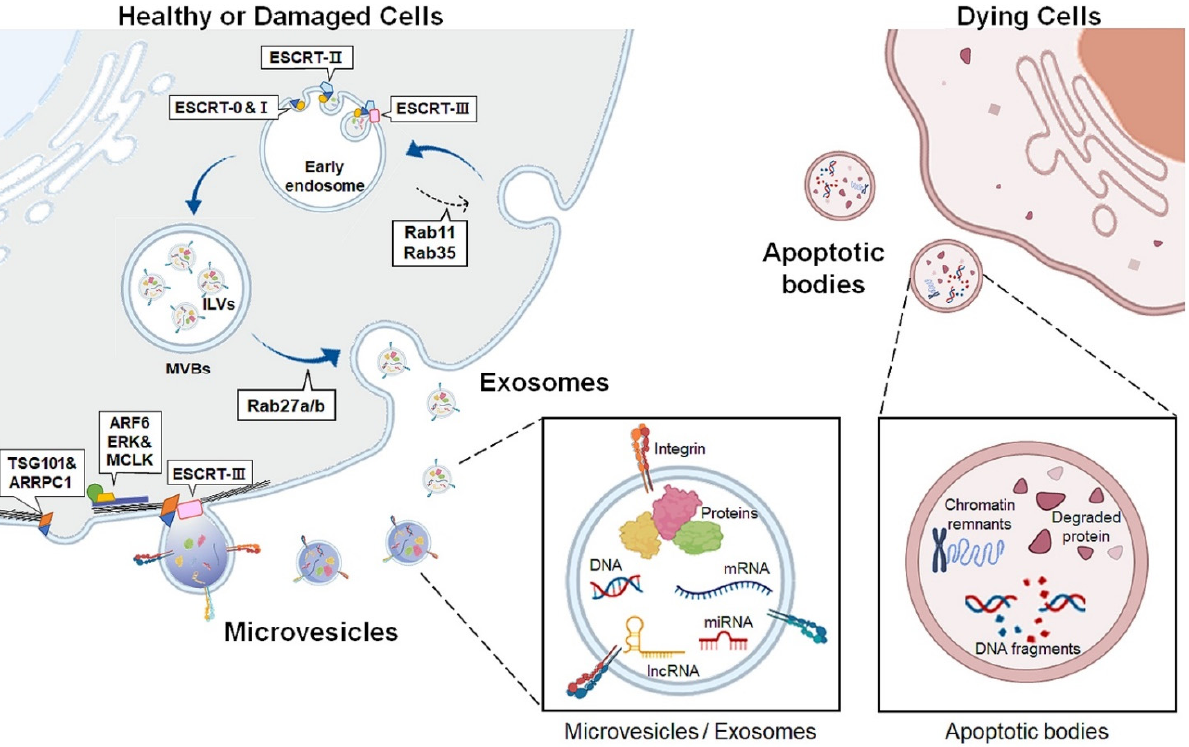
Figure 1. A schematic description of EVs biogenesis and secretion. The schematic representation depicts the production of broad categories of extracellular vesicles (EVs) derived from living cells (left) and apoptotic cells (right). Exosomes originate from the endosomal system. Early endosomes are generated from the inward budding of the plasma membrane, and the early endosomal mem- brane invaginates inward to form intraluminal vesicles (ILVs), maturing into multivesicular bodies (MVBs). In this process, the endosomal sorting complex required for transport (ESCRT) machinery participates in ILV formation. ESCRT-0 recognizes and selects ubiquitinated proteins and recruits ESCRT-I to the endosomal membrane where ESCRT-I forms ESCRT-I/II complex. ESCRT-III, cutting